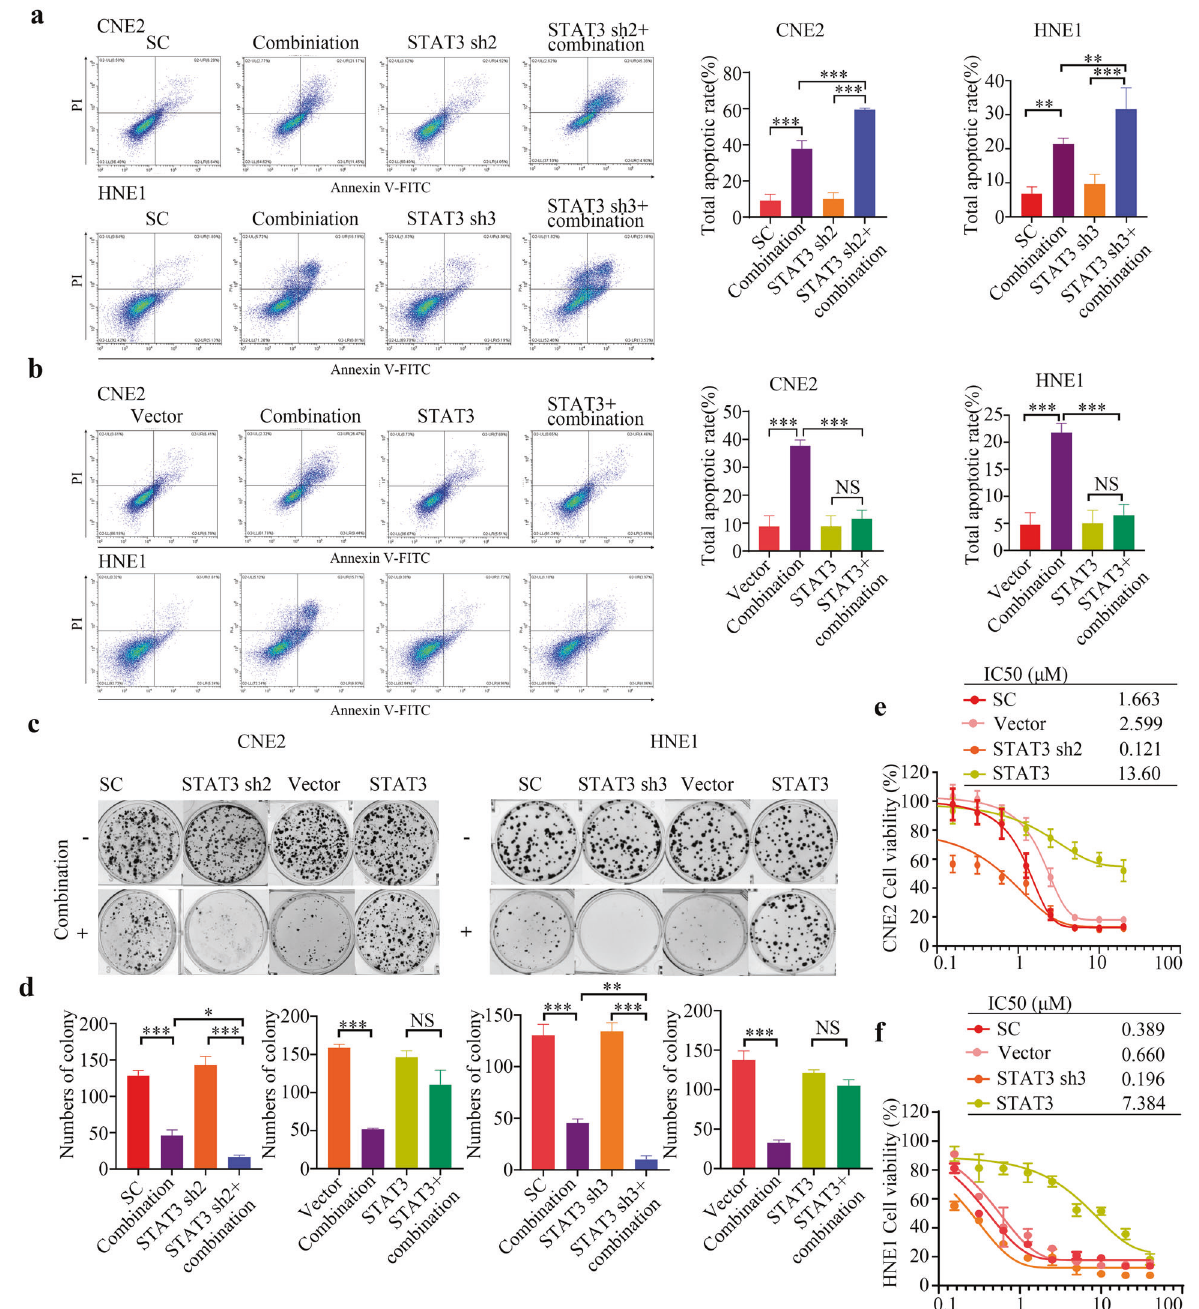
Fig. 6 Gene manipulation of STAT3 affects the enhanced antitumor effect of APG-1252 in combination with gemcitabine. a , b The apoptotic rate of the indicated CNE2, HNE1 cells transfected with the STAT3 shRNA, scrambled control, and STAT3 overexpression vectors after treatment with or without the combination therapy were determined using an Annexin V/PI assay. * P < 0.05, ** P < 0.01, *** P < 0.001. Error bars indicate the standard deviation of three independently performed experiments. c , d Typical images and enumeration of the indicated cells (scramble control, STAT3 shRNA, vector, STAT3 overexpression) treated with or without the combination therapy after crystal violet staining. Data are shown as the mean±SD. * P < 0.05, ** P < 0.01, *** P < 0.001. e , f the CCK-8/IC50 values of the indicated CNE2 and HNE1 cells transfection with the STAT3 shRNA, scrambled control, and STAT3 overexpression vectors after treatment with the combination therapy. * P < 0.05, ** P < 0.01, *** P < 0.001. Error bars indicate the standard deviation of three independently performed experiments. SC Scramble control, PI propidium iodide, STAT3 signal transducer and activator of transcription 3, shRNA short hairpin RNA, CCK-8 Cell Counting